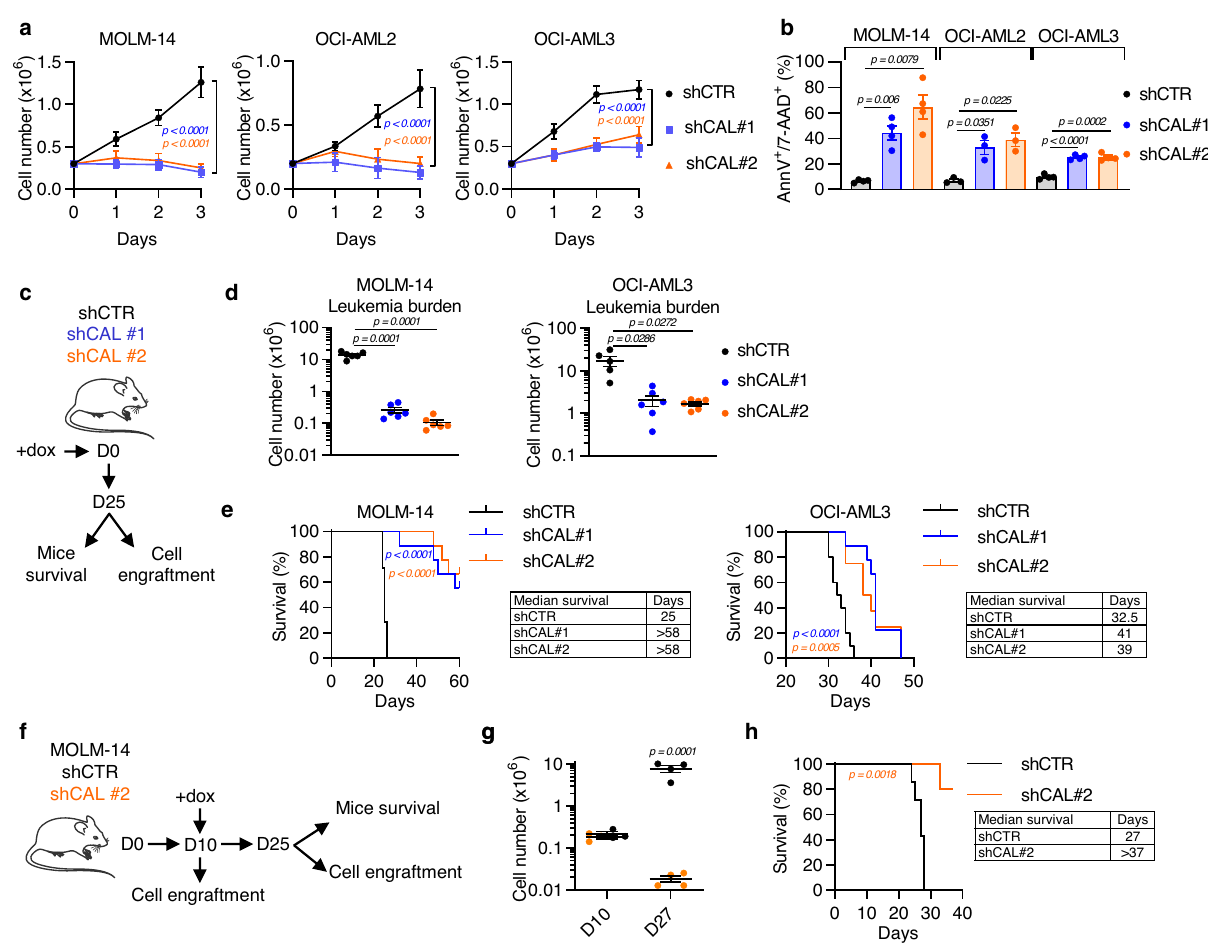
Fig. 2 CALCRL depletion reduces AML cell growth in vitro and in vivo. a-c Control shRNA or shCALCRL were expressed in MOLM-14, OCI-AML2, or OCI-AML3 cell lines. ( a ) Graph shows cell number of MOLM-14, OCI-AML2, or OCI-AML3. Three days after transduction, cells were plated at 0.3 M cells/ ml (D0) and cell proliferation was followed using trypan blue exclusion ( n = 4 independent experiments for OCI-AML2 and n = 6 independent experiments for MOLM-14 and OCI-AML3, two-way ANOVA). ( b ) Graph shows the percentage of Annexin-V + or 7-AAD + cells 4 days after cell transduction ( n = 3 independent experiments for MOLM-14 and OCI-AML3 and n = 4 independent experiments for OCI-AML2, unpaired t- test). ( c ) Investigation of the role of CALCRL on leukemic cell growth in vivo. d Leukemia burden measured using mCD45.1 − /hCD45 + /hCD33 + /AnnV − markers (unpaired t- test). e Mice survival monitoring (Log-rank (Mantel-Cox) test). f Investigation of the role of CALCRL on leukemic cell growth in vivo in a context of engrafted cells. g Measurement of Leukemia burden (unpaired t- test). h Mice survival monitoring (Log-rank (Mantel-Cox) test). Data are mean ±